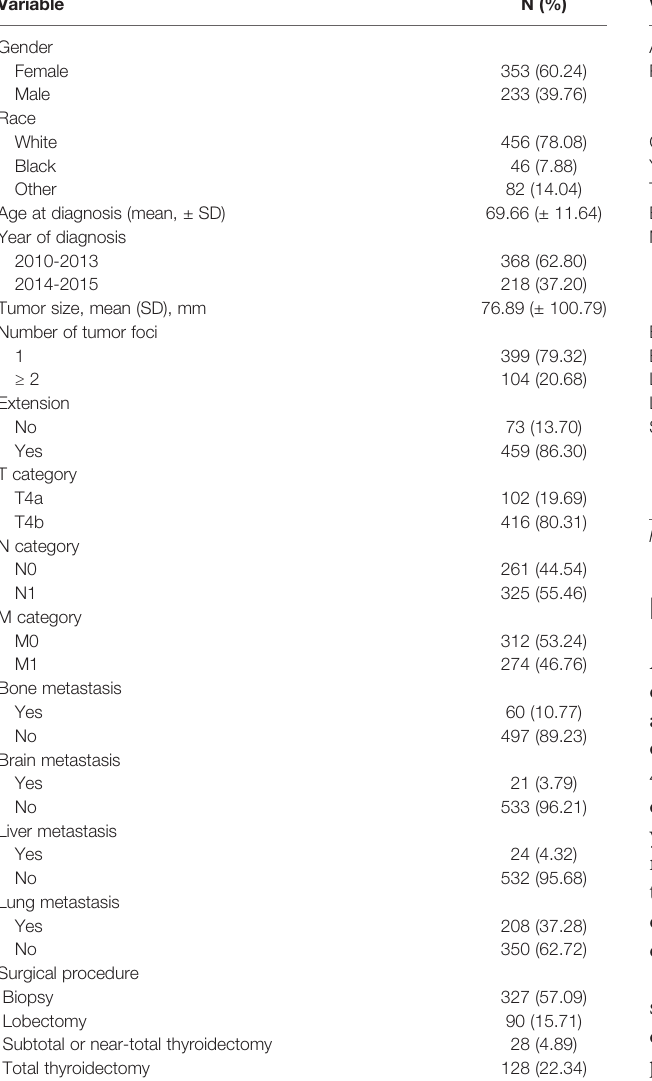
TABLE 2 | Adjusted Cox proportional hazards analyses of cancer-speci fi c mortality for patients with anaplastic thyroid cancer.